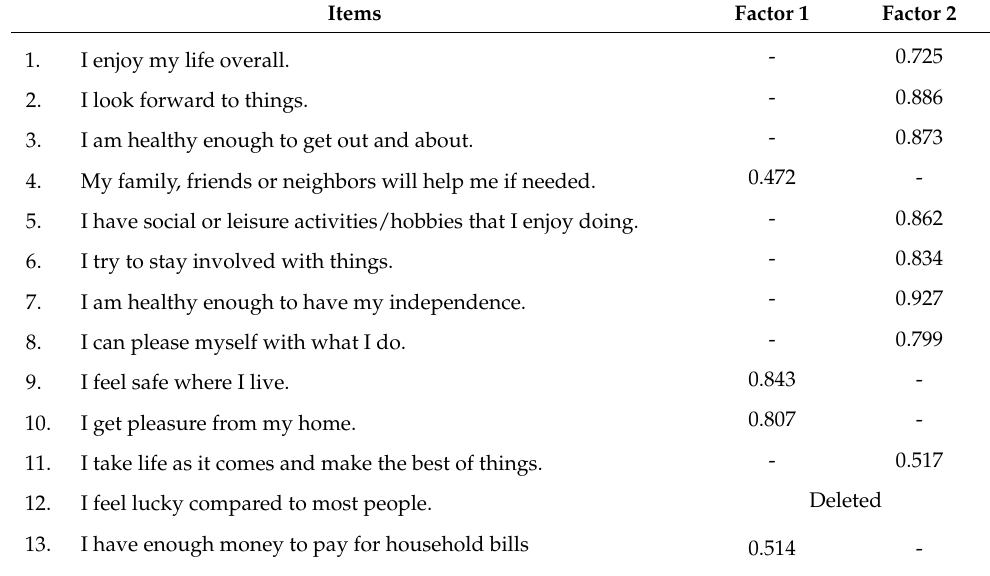
Table 4. OPQOL-Brief rotated factor solution and factors loadings.